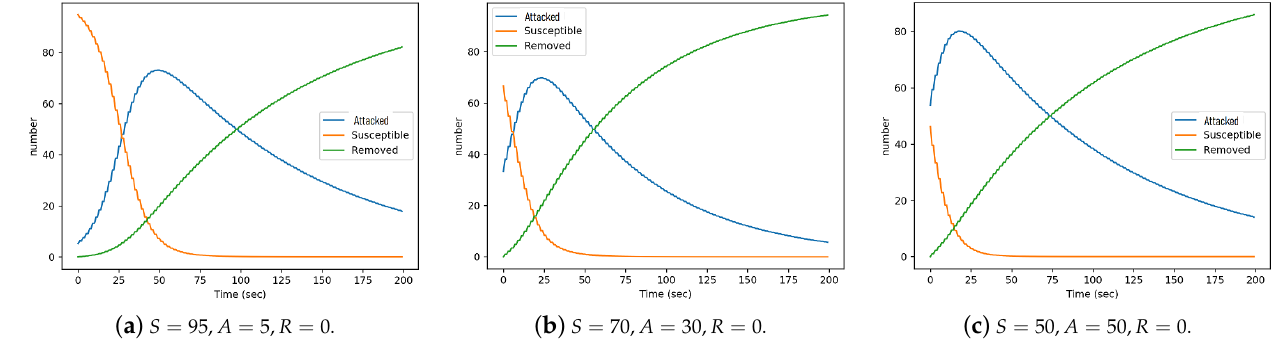
Figure 7. Inbound surveillance scenarios.